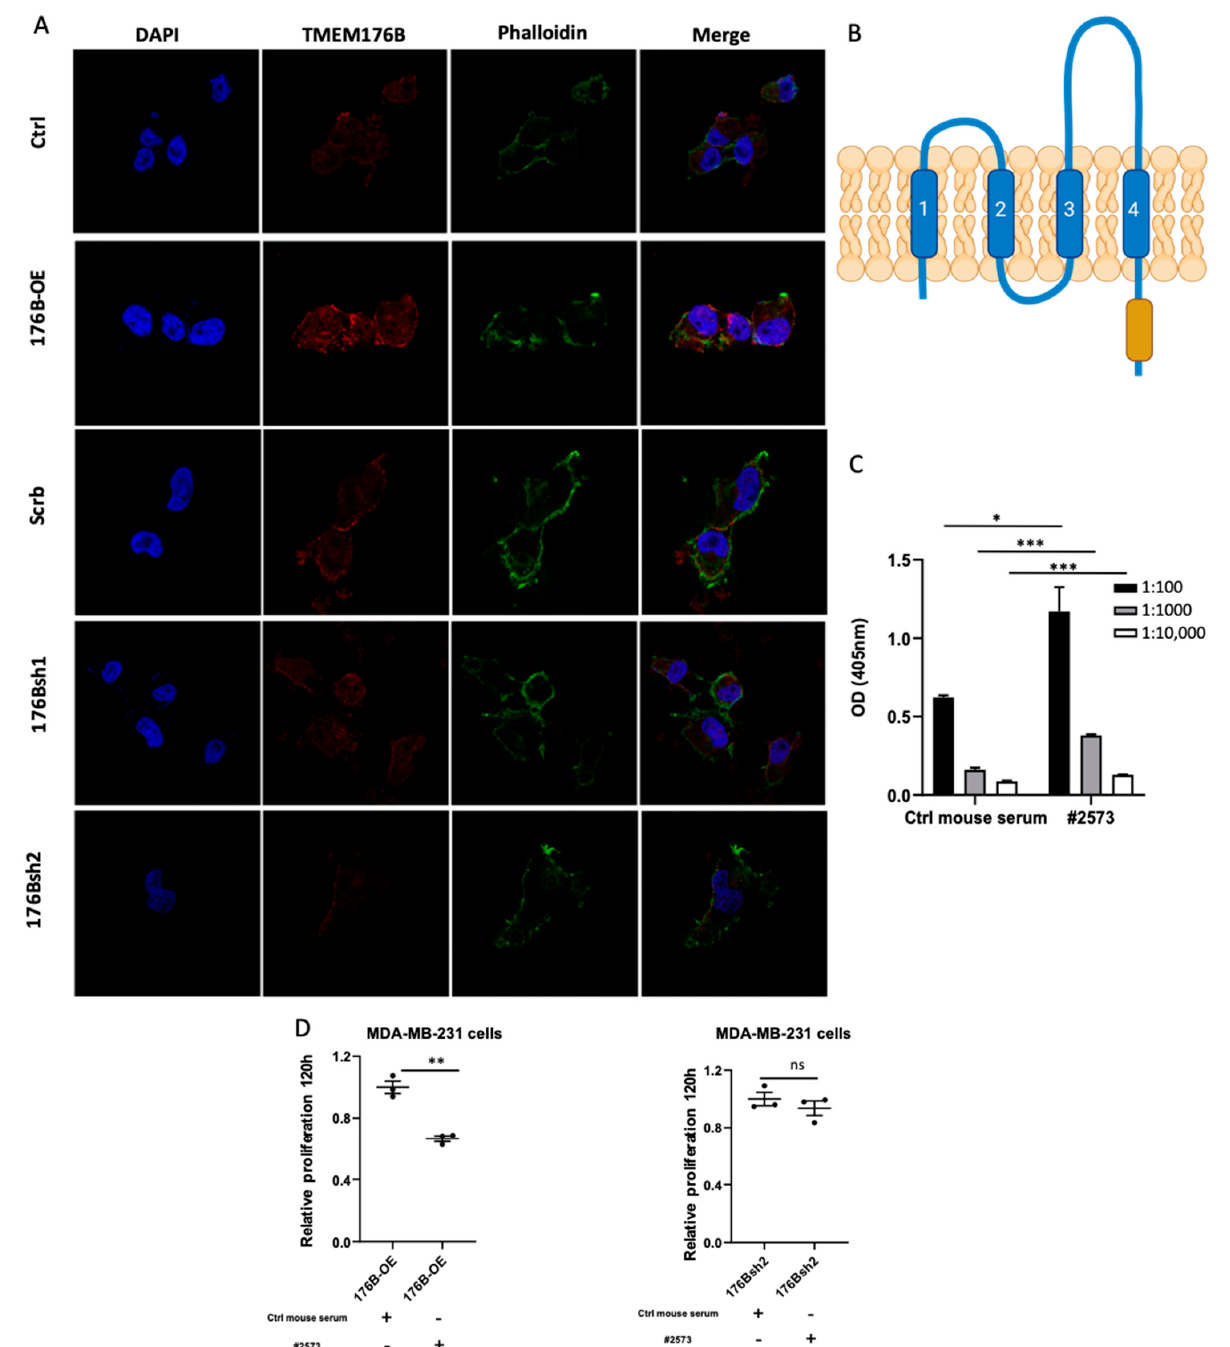
Figure 4. Anti-TMEM176B antibody reduced the proliferation of MDA-MB-231 cells. ( A ) Representative confocal microscopy images of MDA-MB-231 control (Ctrl), TMEM176B-overexpressing (176B-OE), shRNA control (Scrb), and TMEM176B-silenced (176Bsh1, 176Bsh2) cells, stained with TMEM176B and phalloidin (Green) and DAPI nuclear stain (blue). Scale bars, 10 μ m. ( B ) Schematic of TMEM176B transmembrane protein with the large extracellular loop 2, which is larger and more diverse (dashed region) than extracellular loop 1 created with BioRender.com (adapted from reference [2]). ( C ) Quantification of the ELISA assay using the TMEM176B polyclonal antibody targeting the large extracellular loop of TMEM176B (n = 3 per group). ( D ) Proliferation assay of TMEM176B-overexpressing cells and TMEM176B-silenced cells treated with normal mouse serum (control) or anti-TMEM176B pAb-2573 (#2573) at 120 h (n = 3 per group, with two independent experiments). Data are presented as means ± SEM. Differences between groups were evaluated by Student’s t -test ( C , D ). * p < 0.05, ** p < 0.01, *** p < 0.001. ns: not